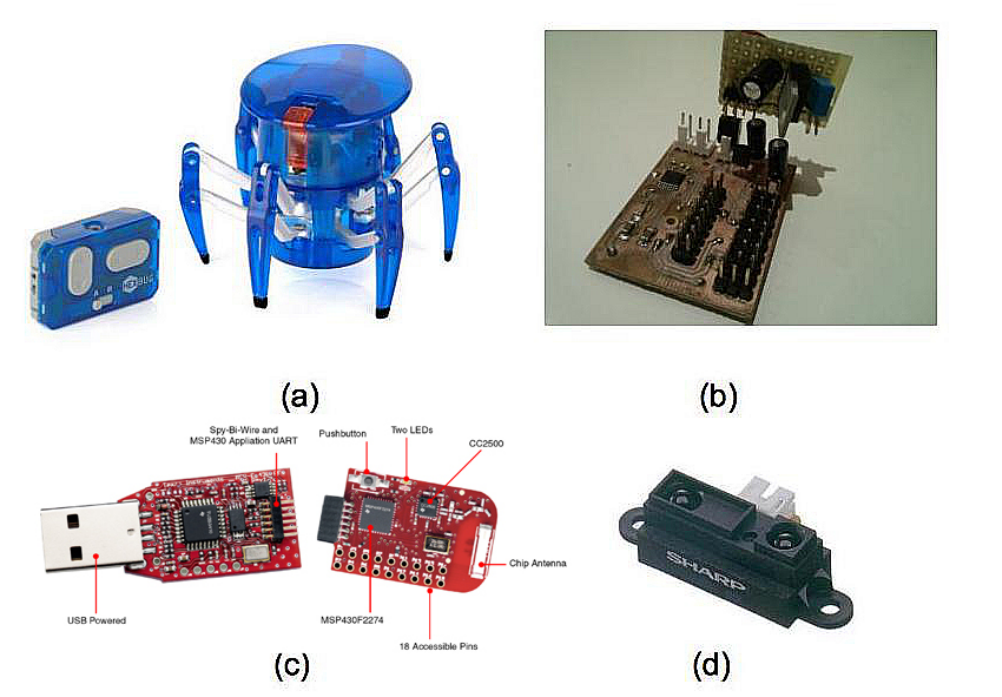
Figure 1. Node hardware structure: ( a ) Hexbug c (cid:13) spider; ( b ) our control board; ( c ) an EZ430-RF2500 kit; ( d ) a SHARP IR range